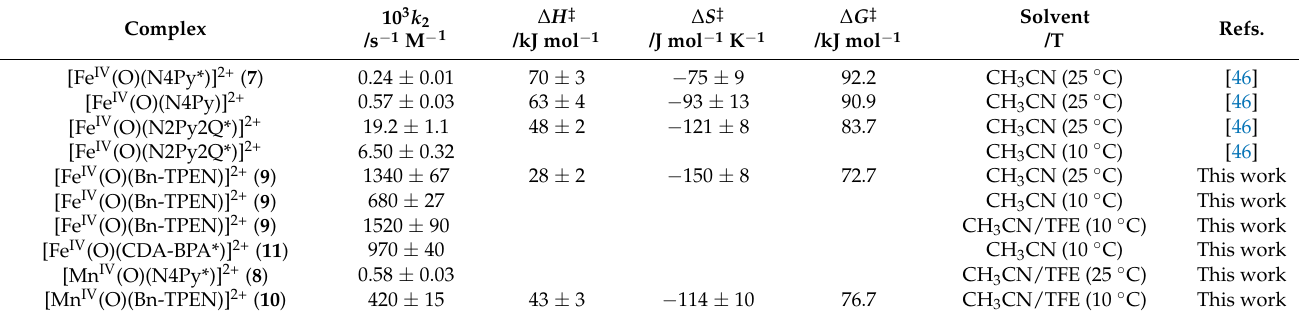
Table 4. Rate constants and activation parameters for the oxidation of flavanone with oxometal(IV) complexes. Complex